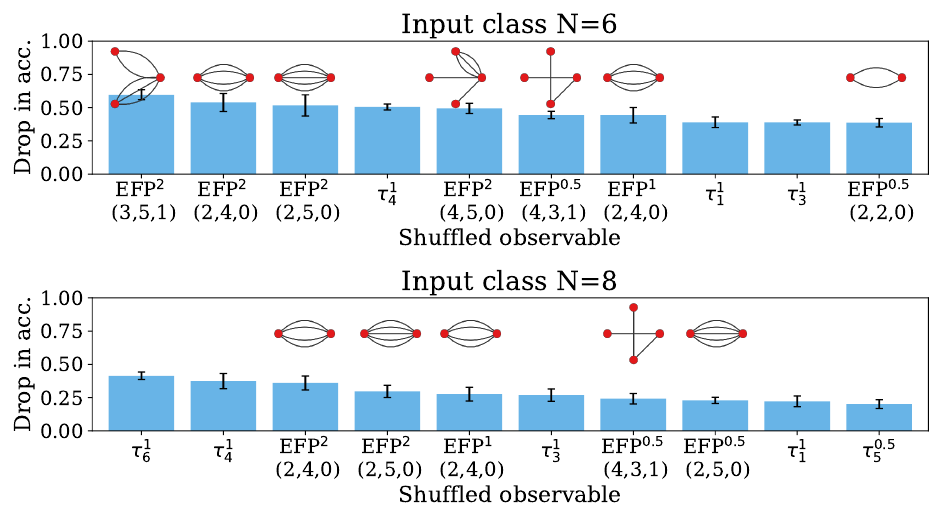
Figure 16 . Accuracy drop and statistical uncertainty of the top 10 observables per input class N = 6 , 8 . The observables are ranked in order of importance, where the most important are those resulting in the largest drops in accuracy of the model when randomly replaced with observable values from the training set. The EFP graphs are included for visualization